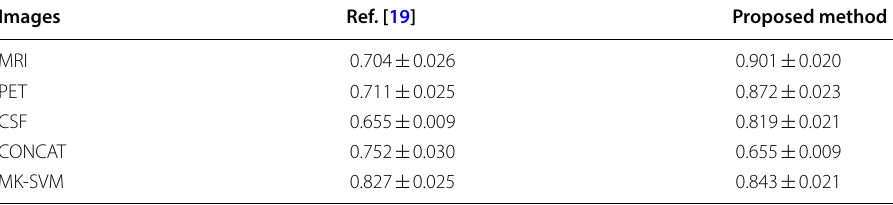
Table 6 The average accuracy of the methods in the AD and MCI classification Images Ref.